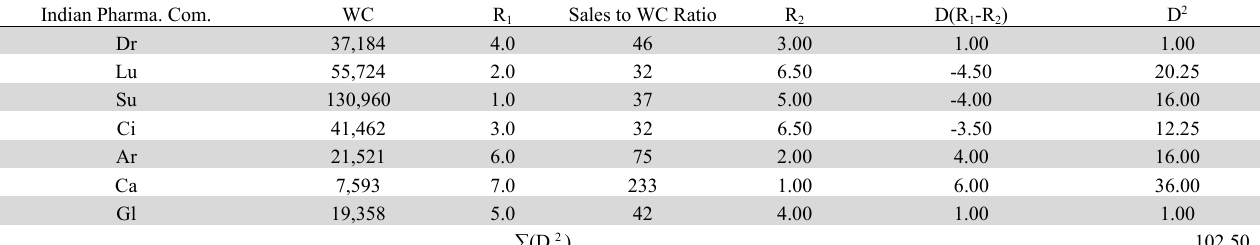
Relational co-movement of working capital and PBT to working capital ratio of selected leading pharmaceutical companies of India Indian Pharma.